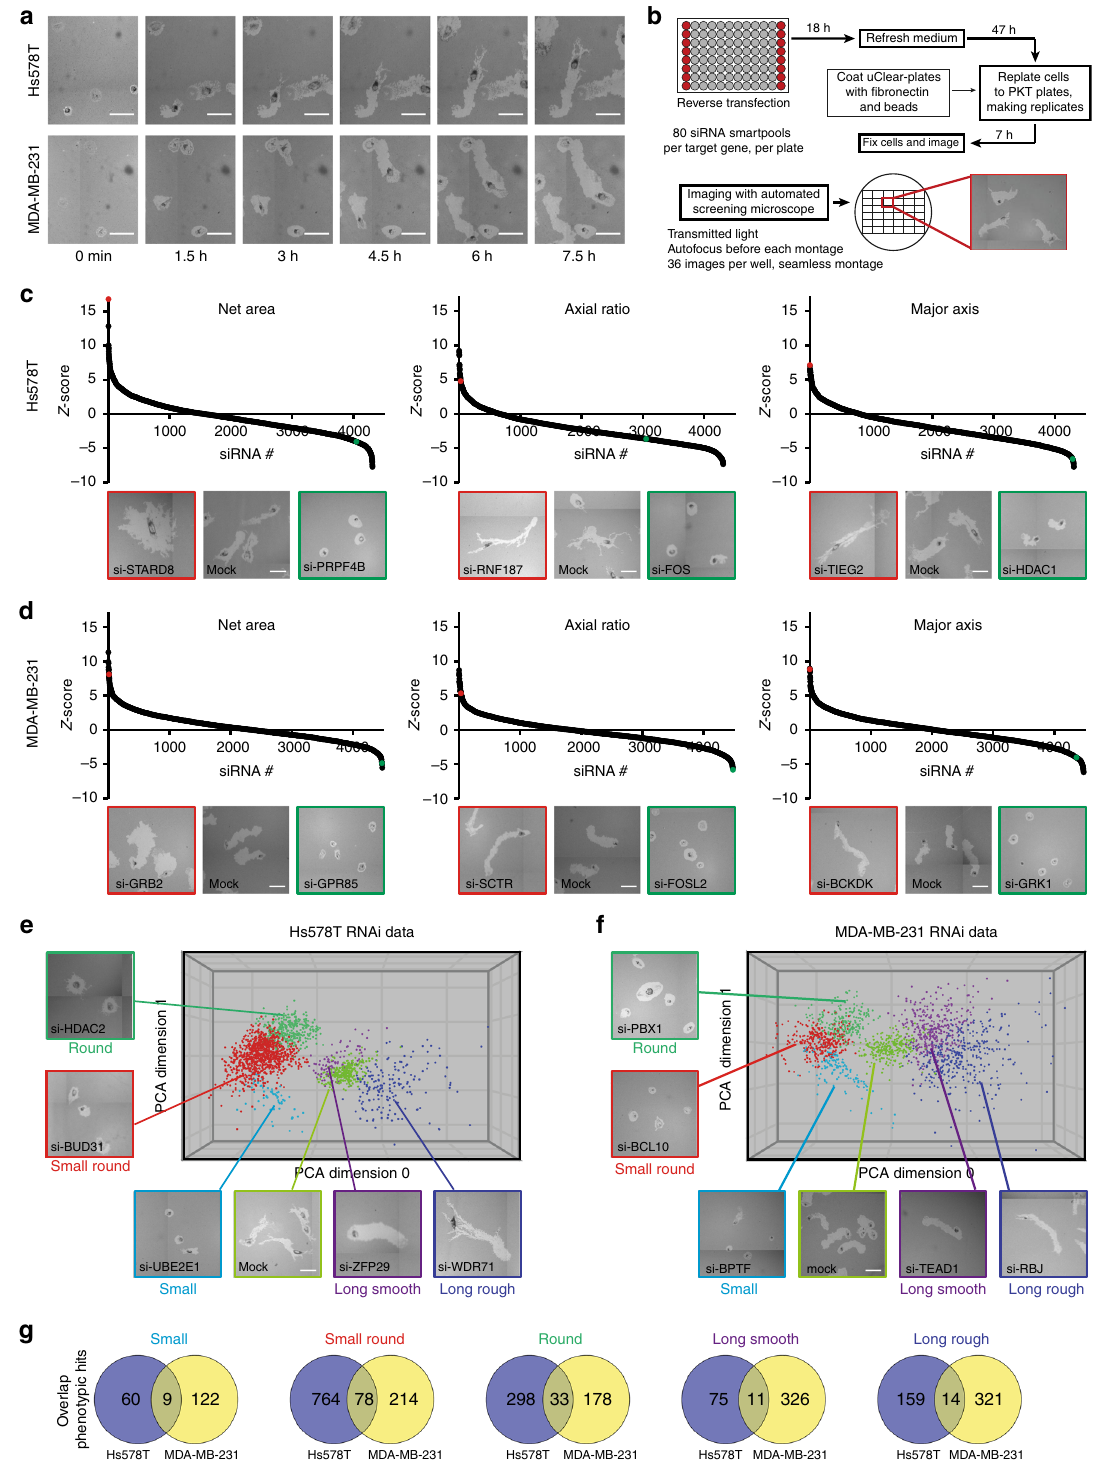
Fig. 1 A phenotypic, imaging-based, RNAi screen identi fi es regulators of tumor cell migration. a Live cell imaging of Hs578T and MDA-MB-231 phagokinetic tracks. Scale bar is 100 µ m. b Schematic representation of PKT screen. Transfection was performed in 96-well plates and controls were included in each plate. After 65h, transfected cells were washed, trypsinized, diluted and seeded in PKT assay plates. Plates were fi xed after 7h of cell migration and whole-well montages were acquired using transmitted light microscopy. For each siRNA knockdown, a robust Z-score was calculated for each PKT parameter. All screening experiments were performed in technical and biological duplicates. c The three most dominant quantitative PKT parameters are shown for Hs578T, and d MDA-MB-231. Representative images of migratory tracks for genes with strong effect are shown below each graph and highlighted for enhancement (red) and inhibition (green). e Principal component analysis of migratory phenotypes in Hs578T, and f MDA-MB-231. Migratory phenotypes were identi fi ed manually and corresponding Z-scores were determined (see the methods section for more details). Only hits in each phenotypic class and mock control are plotted, and representative images of each phenotype are shown. g Overlap of hits in each phenotypic class in both Hs578T and